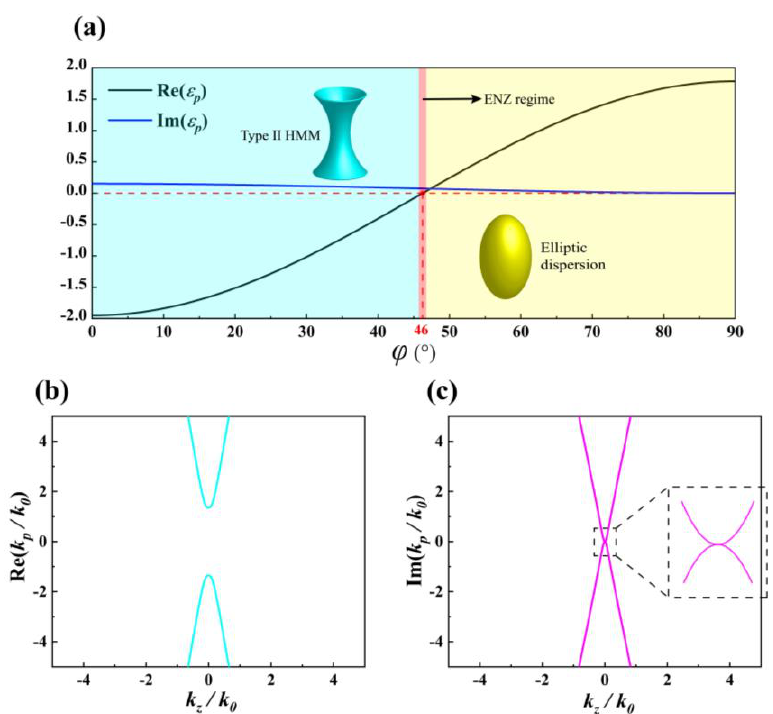
Figure 2. ( a ) Re( ε p )- ϕ (black line) and Im( ε p )- ϕ (blue line) curves. Calculated IFC for ( b ) Re( k p / k 0 ) Figure 2. (a) Re( ε p )- φ (black line) and Im( ε p )- φ (blue line) curves. Calculated IFC for (b) Re( k p / k 0 ) and and ( c ) Im( k p / k 0 ) as a function of k z / k 0 . The other parameters are λ = 5 µ m, ρ = 5 × 10 13 cm − 2 , and (c) Im( k p / k 0 ) as a function of k z / k 0 . The other parameters are λ = 5 μm, ρ = 5 × 10 13 cm −2 , and t d = 300 nm. t d = 300